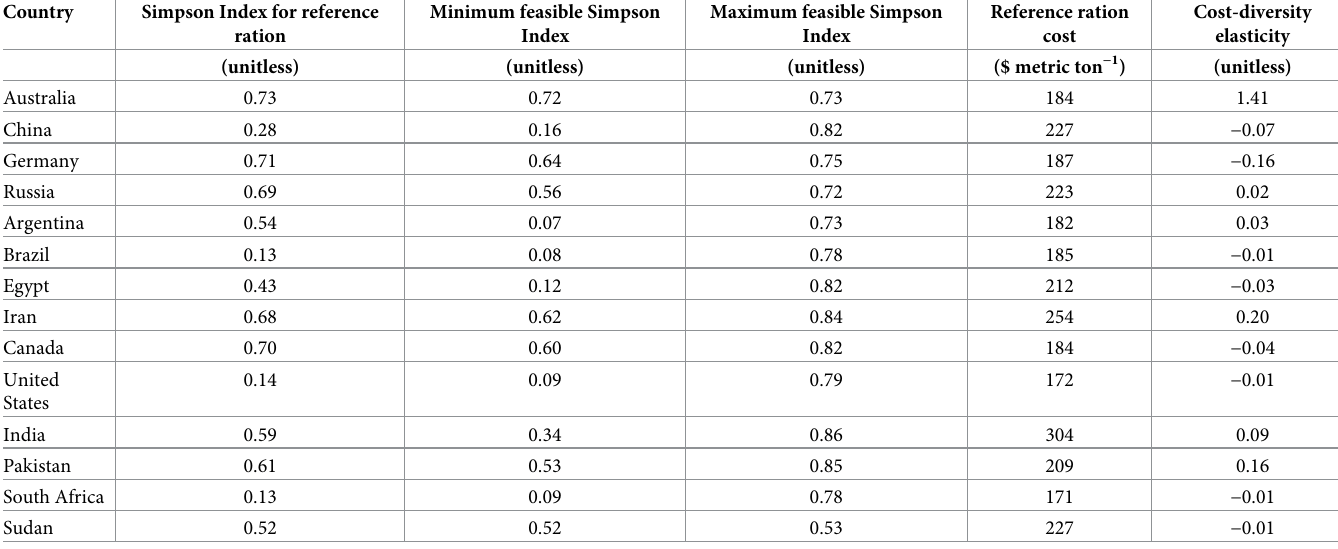
Table 5. Summary, non-inferential, statistics of feed rations for fourteen select